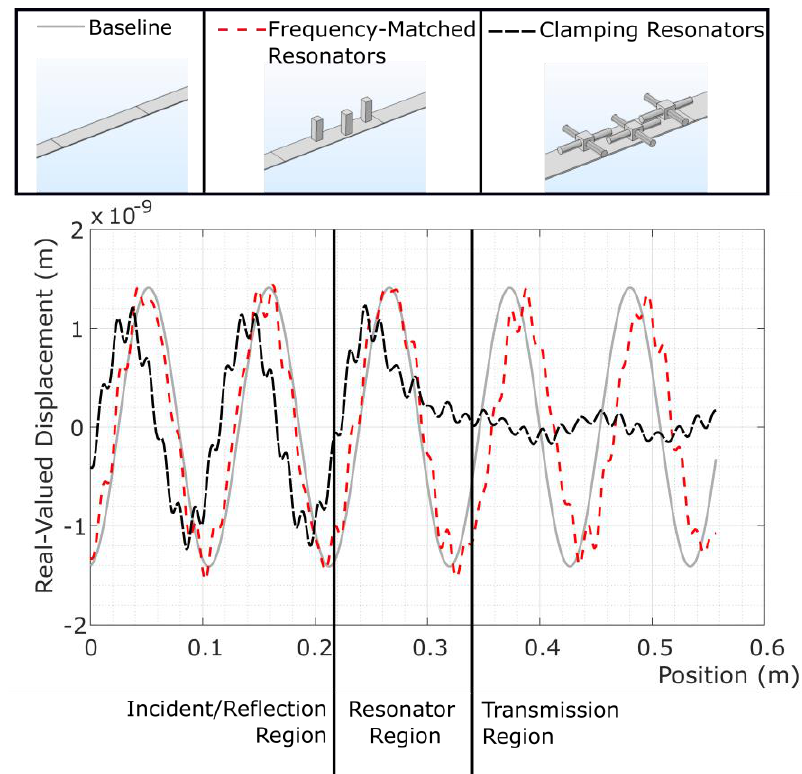
Figure 7. Finite-element predictions of the x -component displacement of an S0 Lamb wave at 50 kHz plotted along the x -axis showing that the clamping resonators block wave propagation, while the frequency-matched resonators do not.